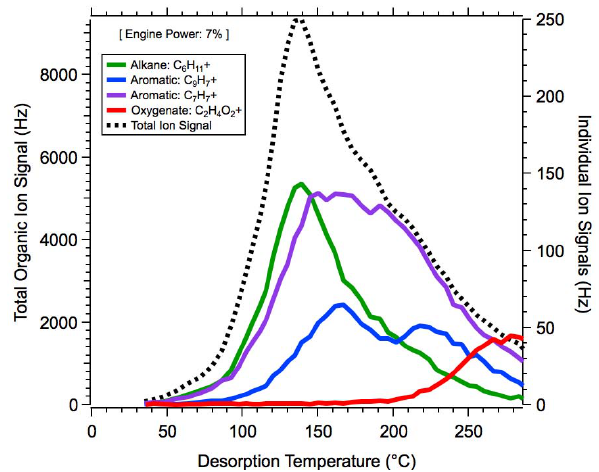
Fig. 7. Selected desorption profiles at 7% engine power. Right axis: total organic ion signal. Left axis: key marker ions of aliphatic ) , aromatic (C 9 H + ) , and oxygenated (C 2 H 4 O + (C 6 H + , C 7 H + 7 7 13 ganic